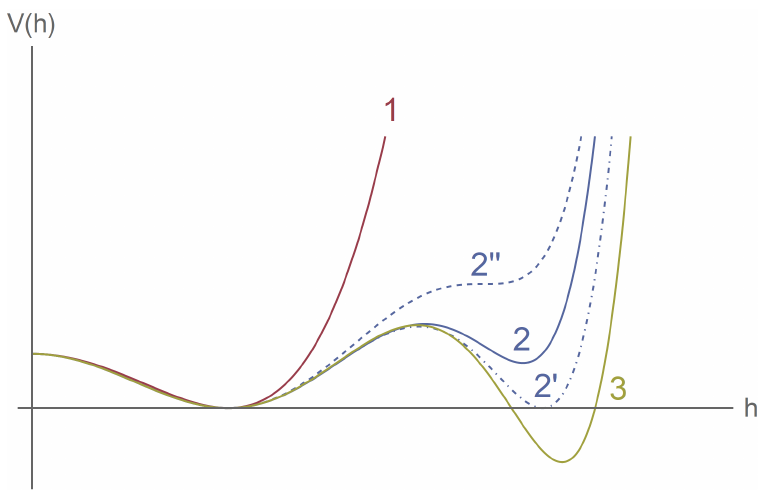
Figure 1 . Schematic shape of the Higgs